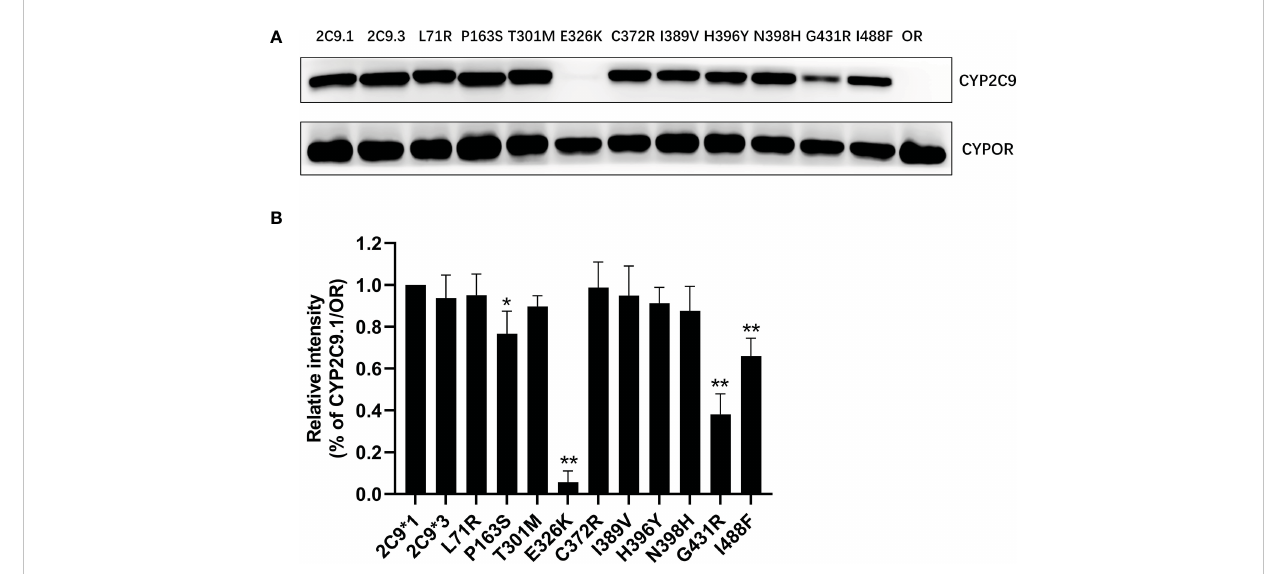
FIGURE 3 The immunoblotting results for expressed CYP2C9 variants in yeast microsomes. (A) Expressed CYP2C9 variants and CYPOR enzyme were detected by their corresponding antibodies after the SDS-PAGE gel separation. OR: microsome from yeast cells only expressing CYPOR enzyme. (B) Relative CYP2C9/OR intensities. Each bar represents the mean ± SD of three independently experiments. *P < 0.05, **P < 0.01 vs CYP2C9.1/OR.